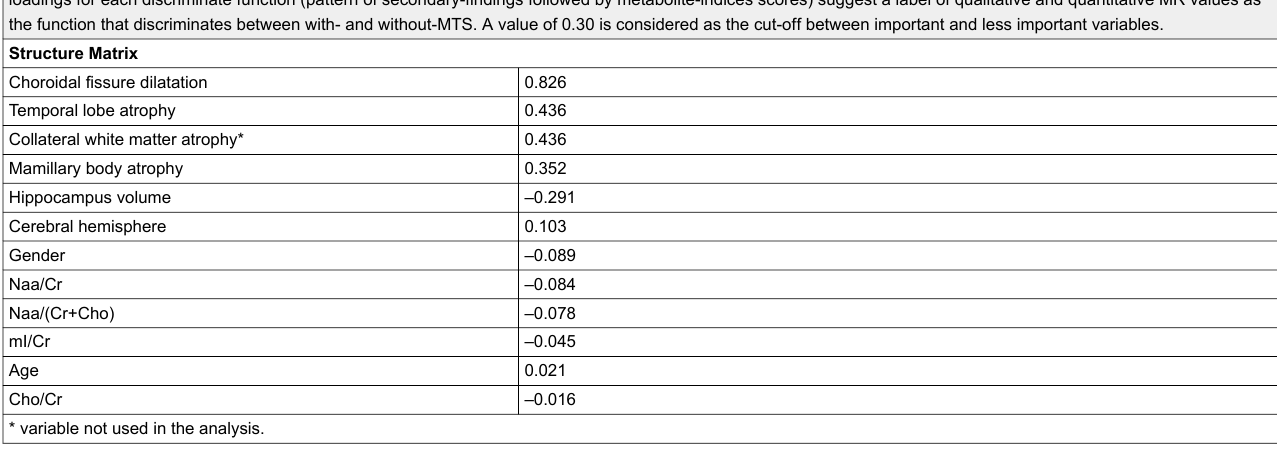
Table 4: Canonical discriminant function coefficients table represent the unstandardized coefficients used to create a discriminant function operating just like a regression equation. Coefficients indicate the partial contribution of each variable to the discriminate function controlling for all other variables in the equation. Canonical discriminant function coefficients